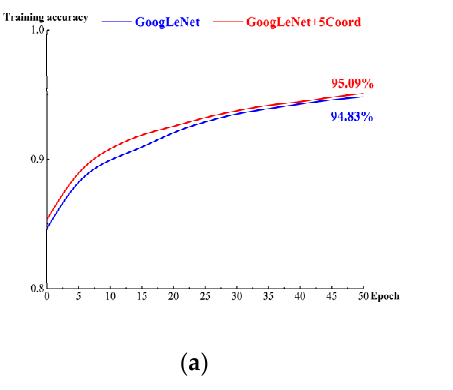
Figure 6. Accuracy and loss of the training dataset when applying two algorithms: ( a ) training ac- curacy; ( b ) training loss. accuracy; ( b ) training